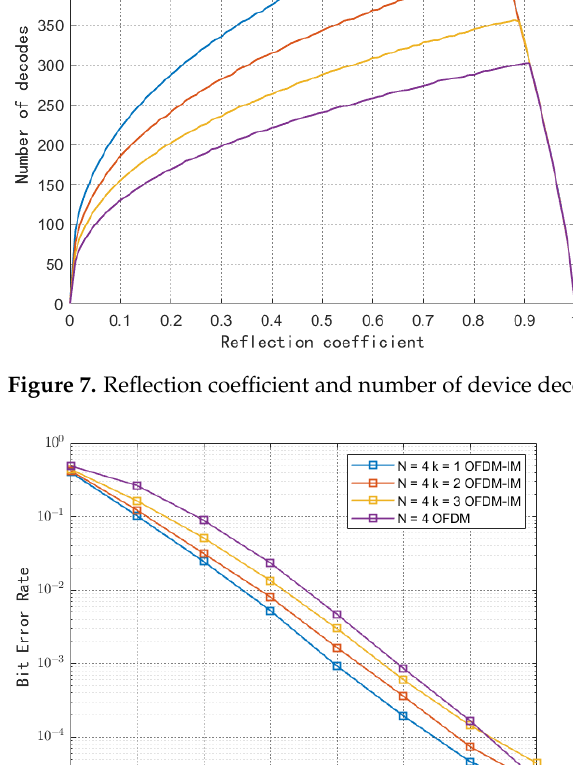
Figure 8. Bit rate of OFDM and OFDM-IM under BPSK modulation.